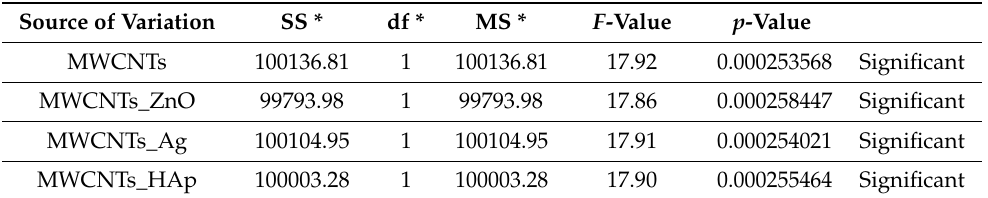
Table 5. ANOVA table for variation in time of relative absorbance for MWCNTs and decorated MWCNTs dispersed in